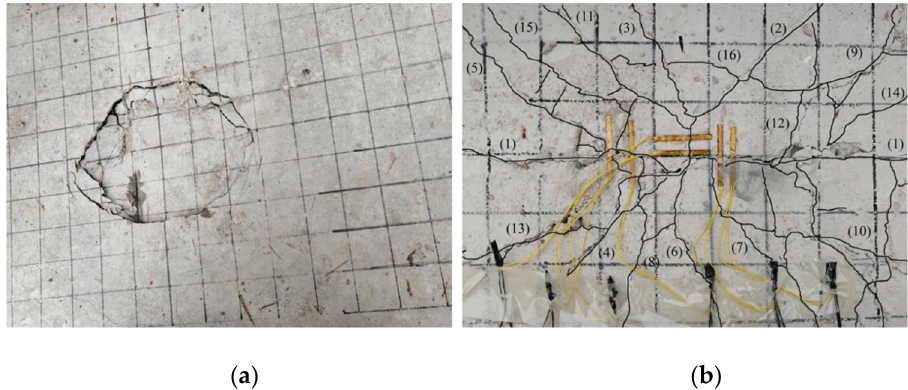
Figure 9. Fatigue test failure of PL2 test beam ( a ) Damage to upper part of bridge deck and ( b ) Damage to lower part of bridge deck.